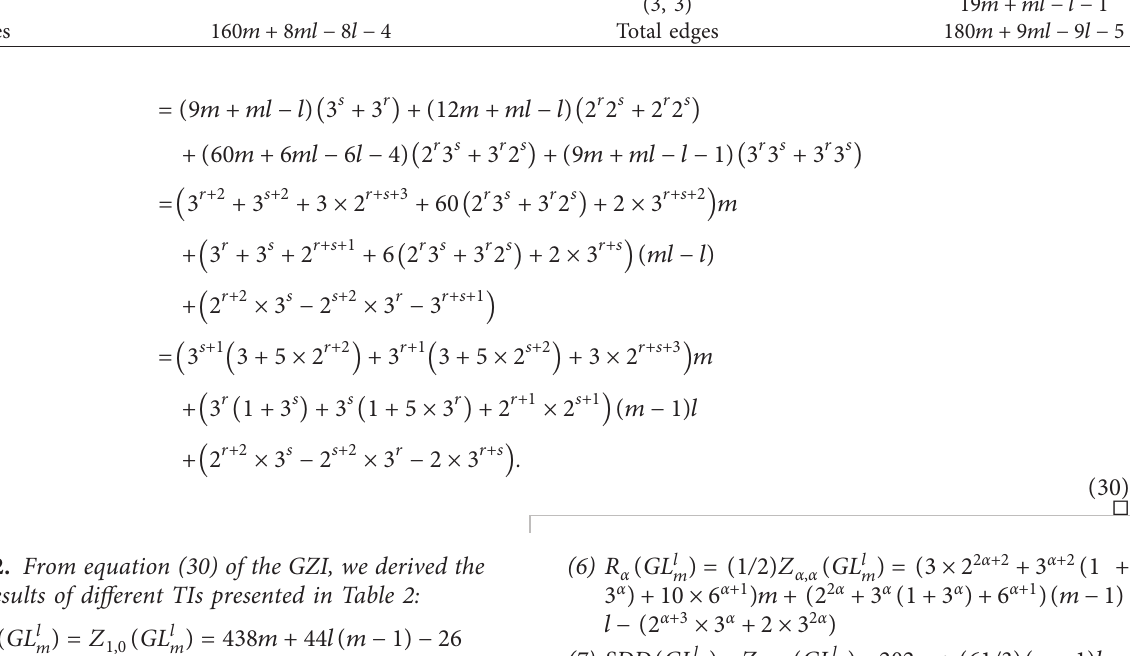
Table 6: Degree-based partitioning of the vertex set and edge set for GL l